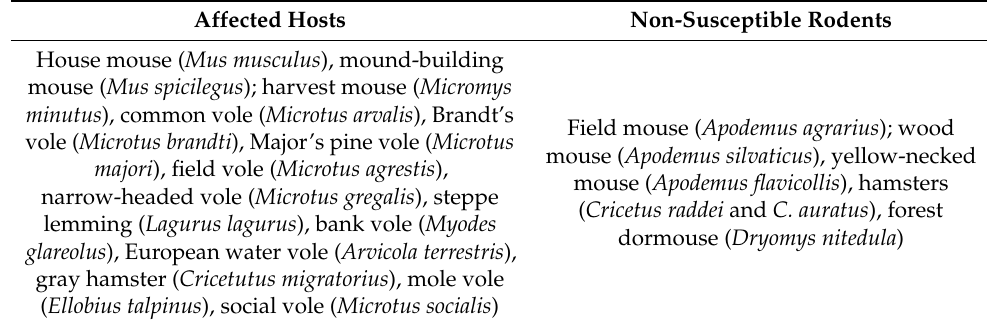
Table 1. Pathogenicity of Salmonella enterica subsp. enterica var. Issatschenko and var. Mereshkowsky to certain rodents. Affected Hosts Non-Susceptible Rodents House mouse ( Mus musculus ), mound-building mouse ( Mus spicilegus ); harvest mouse ( Micromys minutus ), common vole ( Microtus arvalis ), Brandt’s Field mouse ( Apodemus agrarius ); wood vole ( Microtus brandti ), Major’s pine vole ( Microtus mouse ( Apodemus silvaticus ), yellow-necked majori ), field vole ( Microtus agrestis ), mouse ( Apodemus flavicollis ), hamsters narrow-headed vole ( Microtus gregalis ), steppe ( Cricetus raddei and C. auratus ), forest dormouse ( Dryomys nitedula glareolus ), European water vole ( Arvicola terrestris ), gray hamster ( Cricetutus migratorius ), mole vole ( Ellobius talpinus ), social vole ( Microtus socialis )